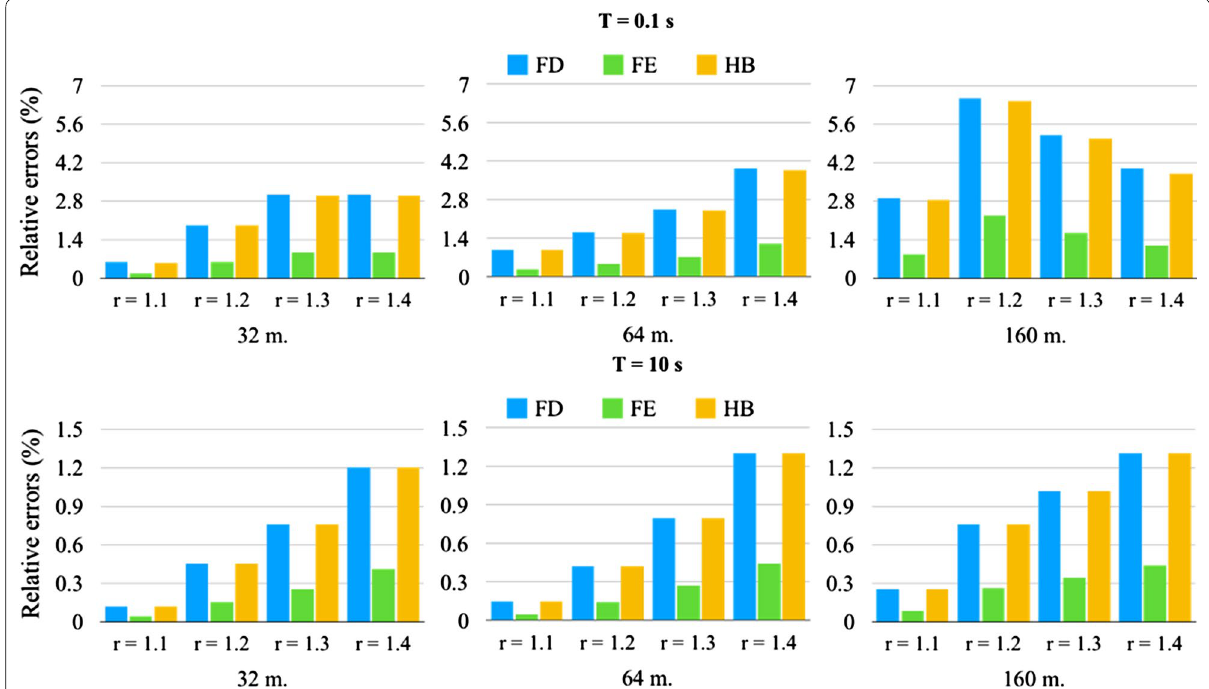
Fig. 6 Relative errors (%) of apparent resistivity calculated at T = 0.1 (top) and 10 s (bottom) for the two-layered